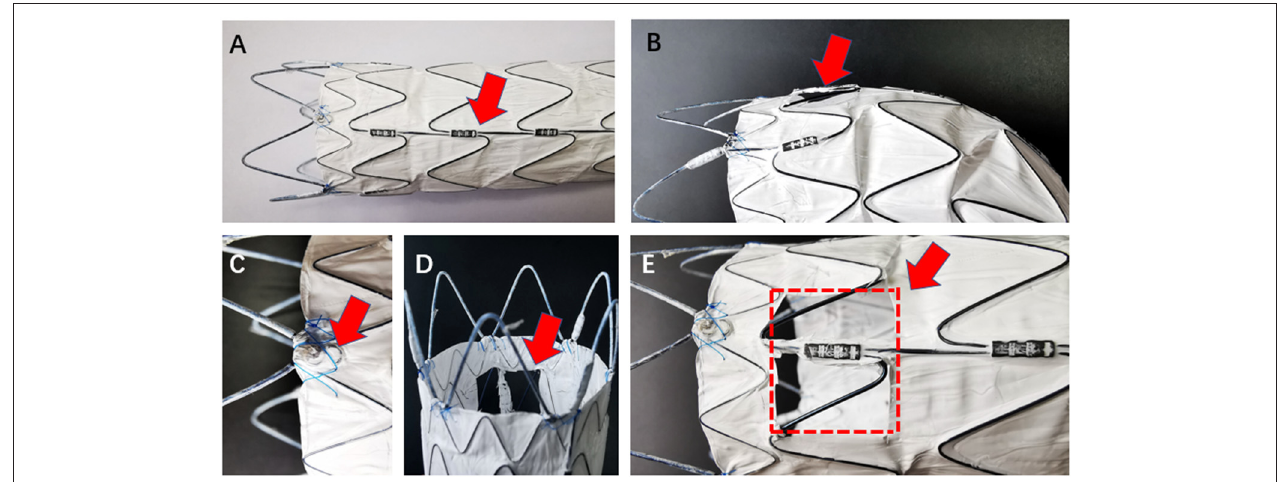
FIGURE 1 | The model stent-graft (LifeTech Co., Shenzhen, China) shows radiopaque marker and formation after fenestration in different angle. (A) Red arrow shows the longitudinal strength strut, which is visible on radiation monitor; (C) red arrow shows the “ ∞ ” radiopaque marker at the proximal site of the membrane edge; (B,D,E) fenestration in multiple angles. Red arrows show the complete fenestration. Red dot-line shows the area and position of the fenestration.